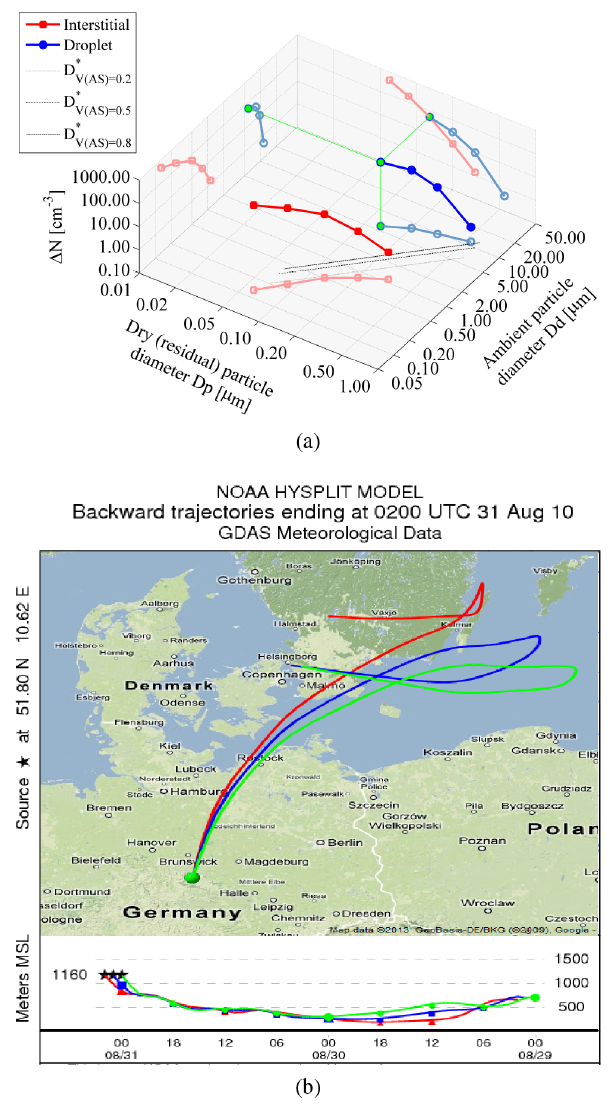
Fig. 3. (a) Concentration in each measured size interval 1N of droplets and residual particles as a function of ambient particle and dry particle diameter on 31 August 2010, 23:51UTC. The three black lines in the D P – D d plane indicate the critical diameter of activation according to Köhler’s theory for different volume frac- tions of ammonium sulfate in the particles, D ∗ . The projec- V(AS) tions in paler colors show the distribution of ambient particles (left, D d – 1N plane), the distribution of dry (residual) particles (right, D P – 1N plane) and ambient particle diameter D d as a function of dry (residual) particle diameter D P (bottom, D P – D d plane). (b) The 48h back trajectories arriving at Mt. Brocken at 23:00UTC, 30 August 2010 (green) and 01:00UTC (blue) and 02:00UTC (red), 31 August 2010, derived with the HYSPLIT model are shown. The HYSPLIT trajectories arrive at 1161ma.s.l., representing 20m above the station at the summit of Mt. Brocken (Draxler and Rolph,